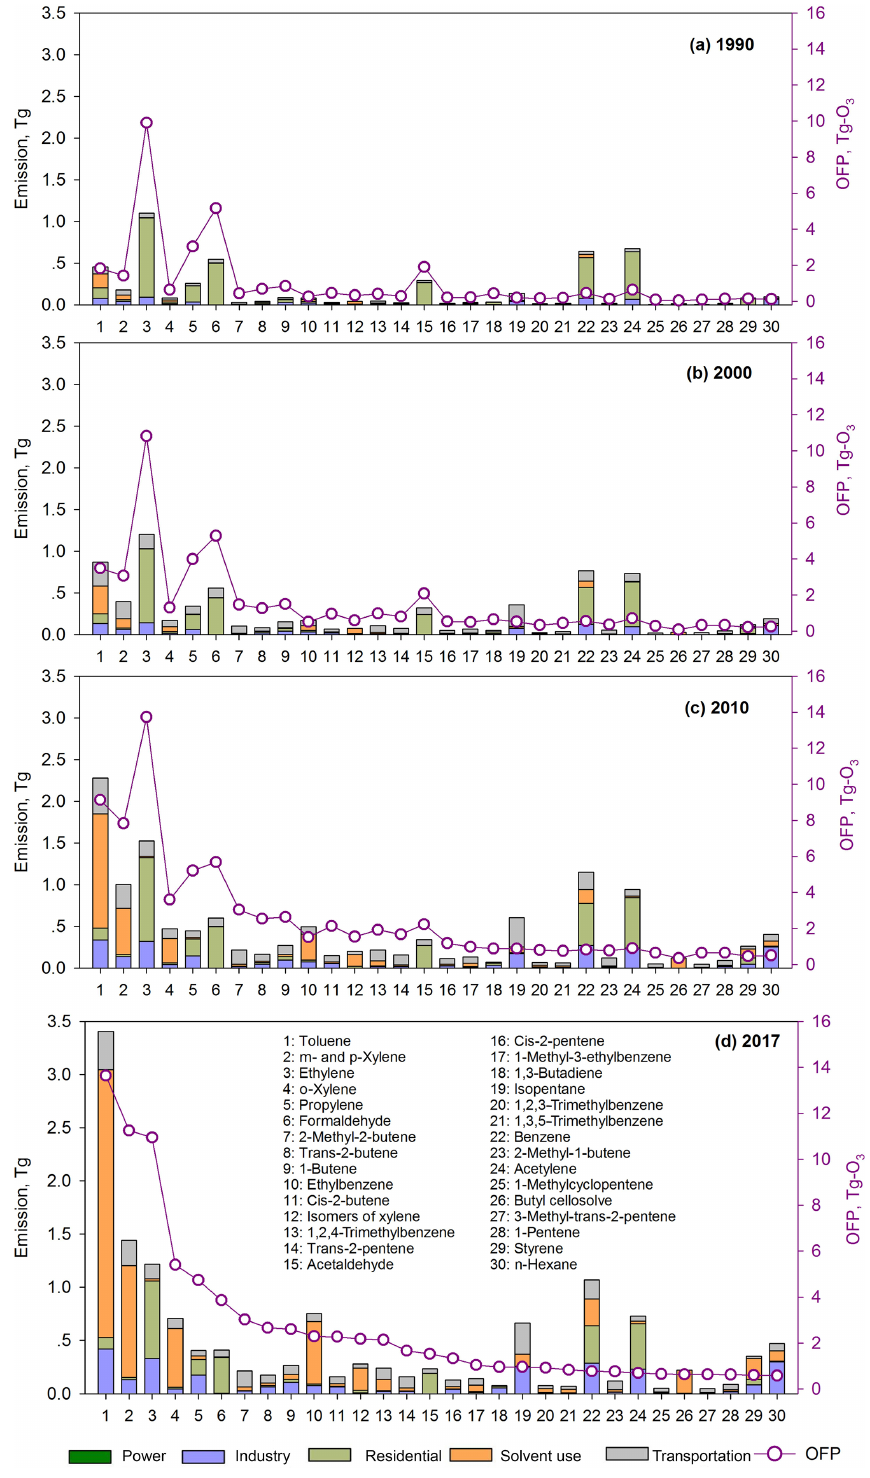
Figure 3. Emissions of the top 30 species contributing to OFP in 2017 in an OFP-descending order by sector in 1990 (a) , 2000 (b) , 2010 (c) and 2017 (d)